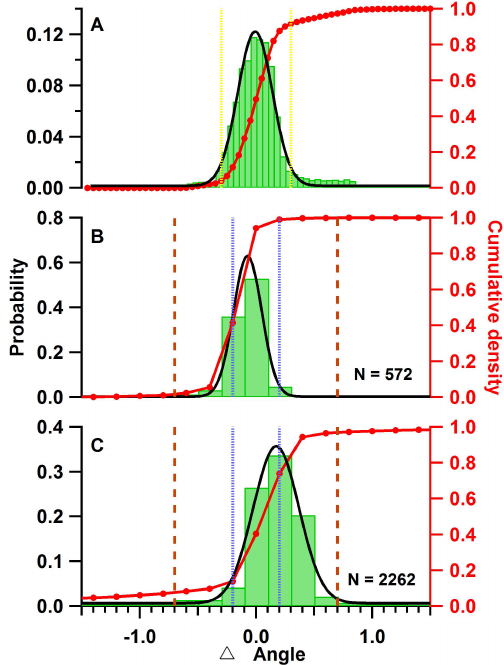
Fig. 3. (A) Distribution of difference in pitch angle of the aircraft measured at real time by the MMQ-G angle sensor of the CU- AMAX-DOAS and aircraft avionics system of NSF/NCAR GV HI- APER aircraft during a research flight on 24 February 2012. 1 σ angle accuracy (0.29 ◦ ) of the MMQ-G sensor is shown in yellow dotted lines. 1 σ for the Gaussian fit (black line) is 0.15 ◦ . Distri- bution of elevation angle accuracy of the CU AMAX-DOAS tele- scope (B) from the above-mentioned flight on NSF/NCAR GV HI- APER flight and (C) during RF#46 aboard NOAA Twin Otter on 16 July 2010. 1 σ for the Gaussian fits (black lines) are 0.12 ◦ and 0.2 ◦ for instrument aboard HIAPER and Twin Otter aircraft, respec- tively, and are within the resolution of the motor internal encoder (0.2 ◦ ), shown in blue dotted lines. Brown dashed lines represent the motor tolerance level (0.7 ◦ ) set in the software before an automatic reset of the motor position takes place. The red lines represent the cumulative